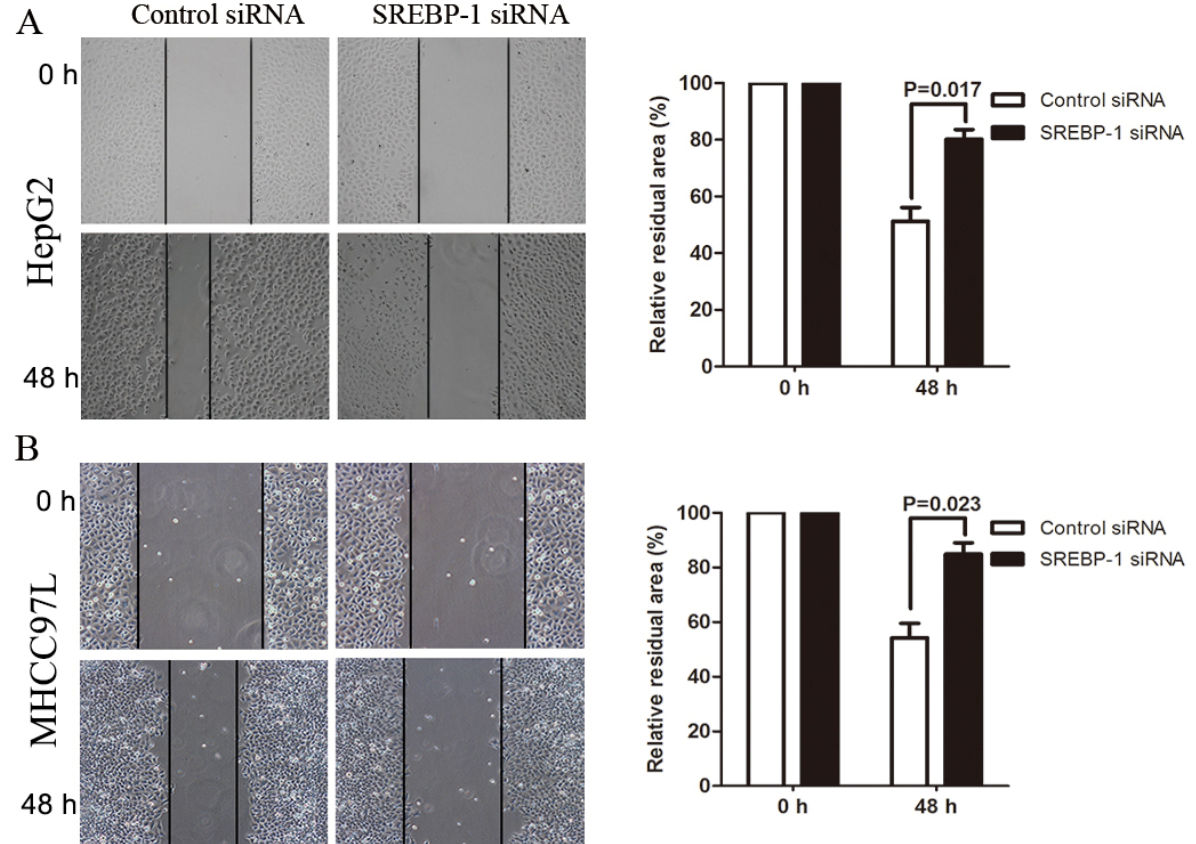
Figure 5. SREBP-1 regulates migration of HepG2 and MHCC97L cells. Wound healing assays showed that SREBP-1 knockdown reduced the migration of ( A ) HepG2 cells and ( B ) MHCC97L cells (original magnification ×100). n = 3. Data show representative results of repeat experiments. Values are depicted as mean ±